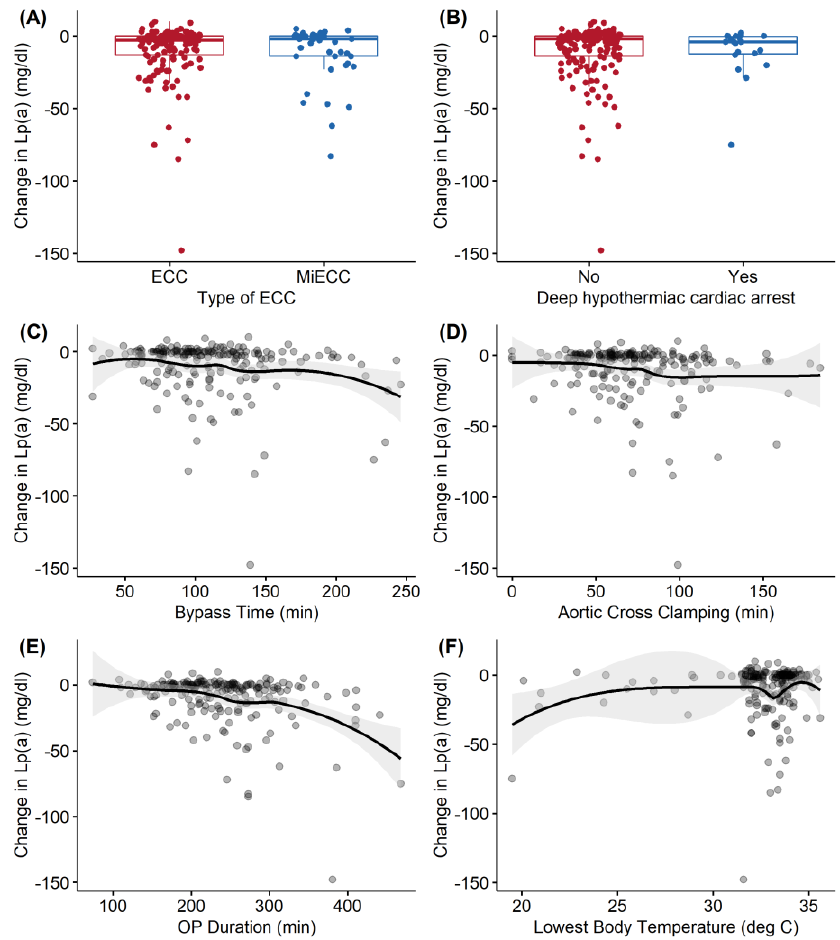
Figure 3. Bivariate associations of surgical characteristics with the change in Lp(a) from preoperative to postoperative values. Boxplots are shown for categorical variables ( A , B ), and locally estimated scatterplot smoothing (LOESS) estimates and their associated 95% confidence intervals (grey shading) are depicted for continuous variables ( C – F ). Each dot represents the change in Lp(a) for an individual patient.